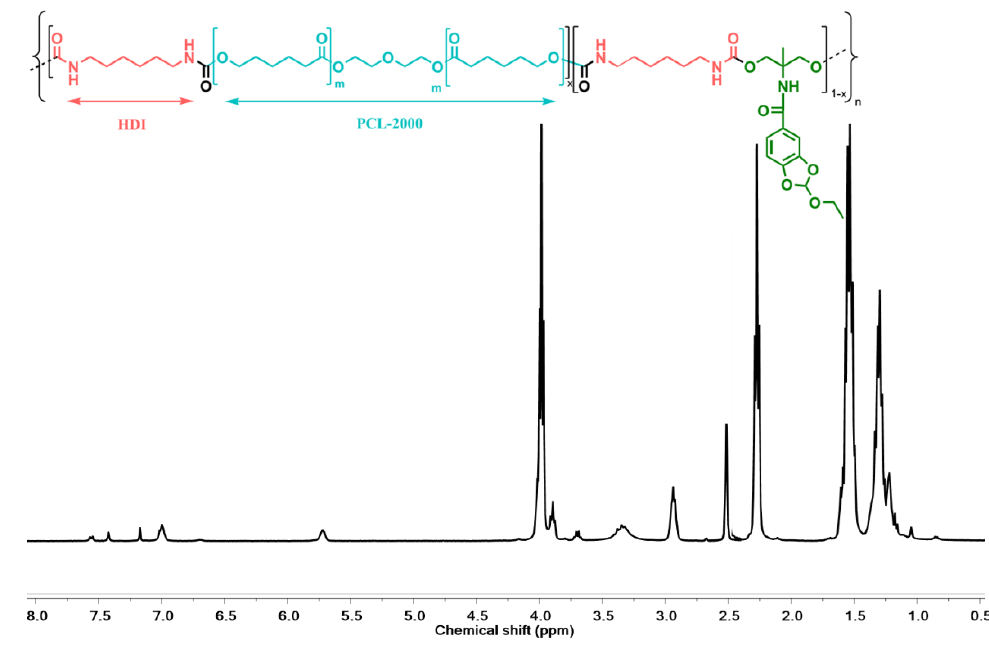
Figure 6. The 1H-NMR spectrum of polyurethane functionalized with protected catechol motifs.